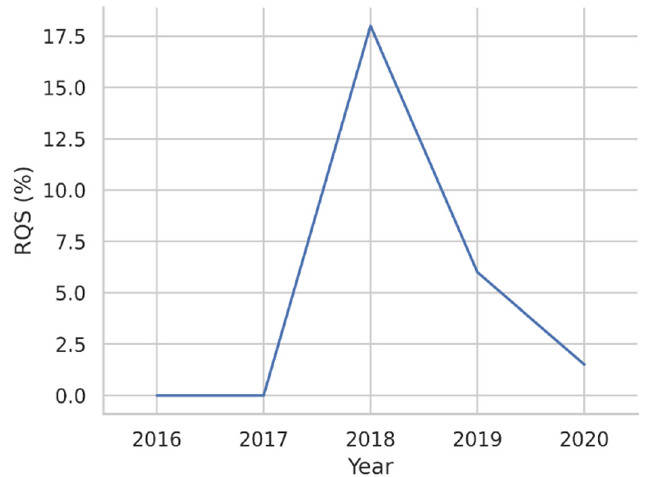
Figure 4. Line plot depicting the median RQS percentage score in relation to publication year.